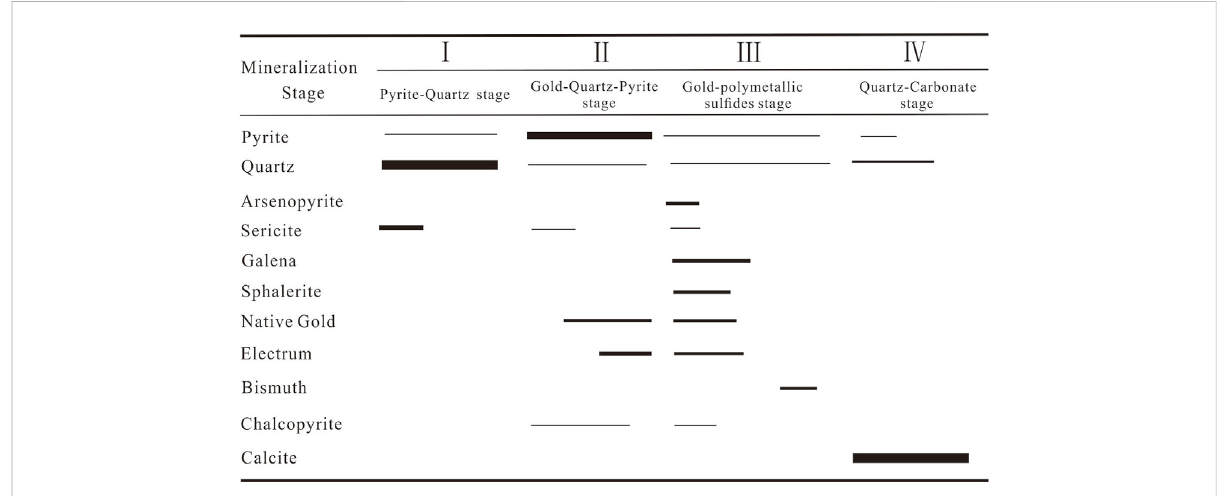
FIGURE 5 Paragenetic sequence of the Houge ’ zhuang gold deposit. Thick lines: high abundance. Thin lines: low abundance.